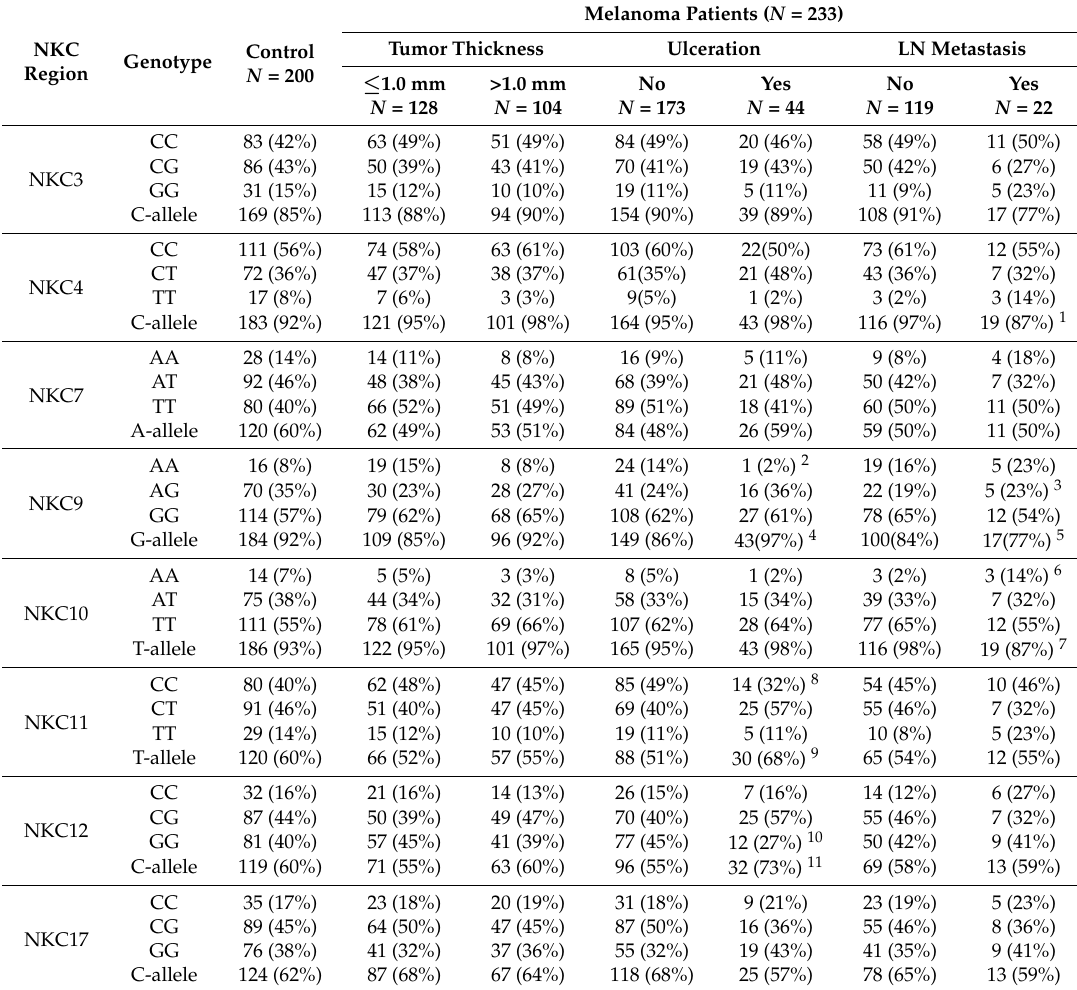
Table 3. NKC allele and genotype frequencies in healthy controls and melanoma patients according to clinical characteristics at